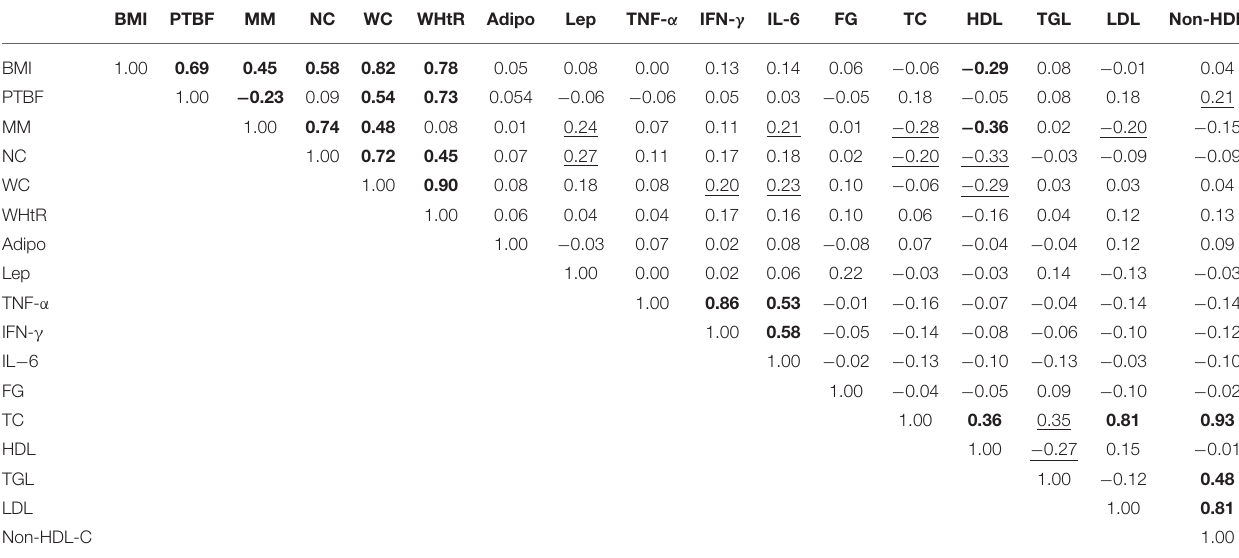
TABLE 9 | Simple Pearson’s correlation coefficients (r) for the total sample between anthropometric parameters, body composition, adipocytokines, and cytokines. BMI PTBF MM NC WC WHtR Adipo